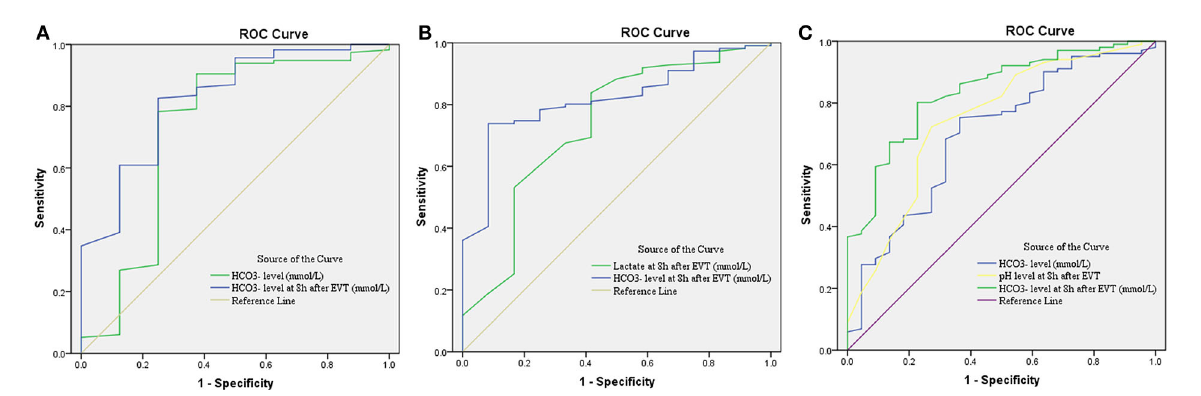
FIGURE3 Receiver operating characteristic (ROC) curve for predicting sICH (A) , hemicraniectomy (B) , and mortality (C) in patients with endovascular thrombectomy. CI, confidence interval; EVT, endovascular treatment; HCO − 3 , bicarbonate; sICH, symptomatic intracranial hemorrhage.